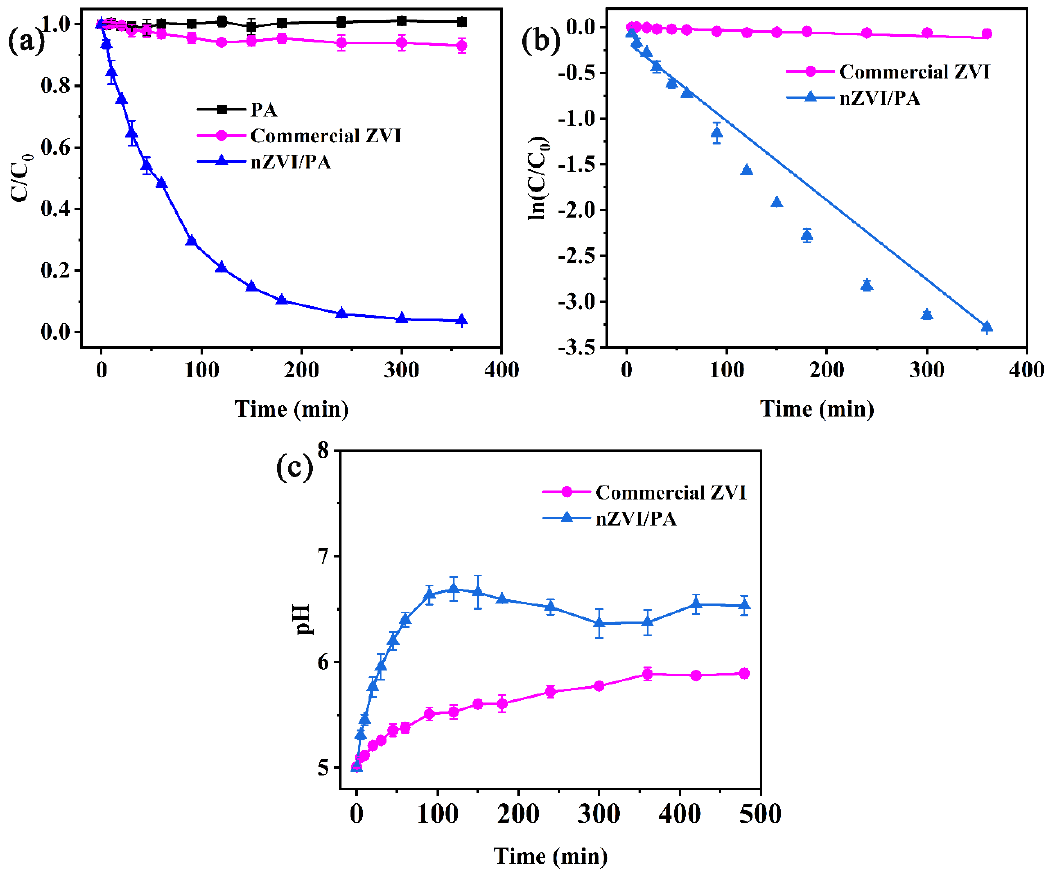
Figure 6. Time-dependent degradation ( a ), pseudo-first order kinetic curves ( b ), and pH variation ( c ) in the reaction of CIP by ZVI/PA.